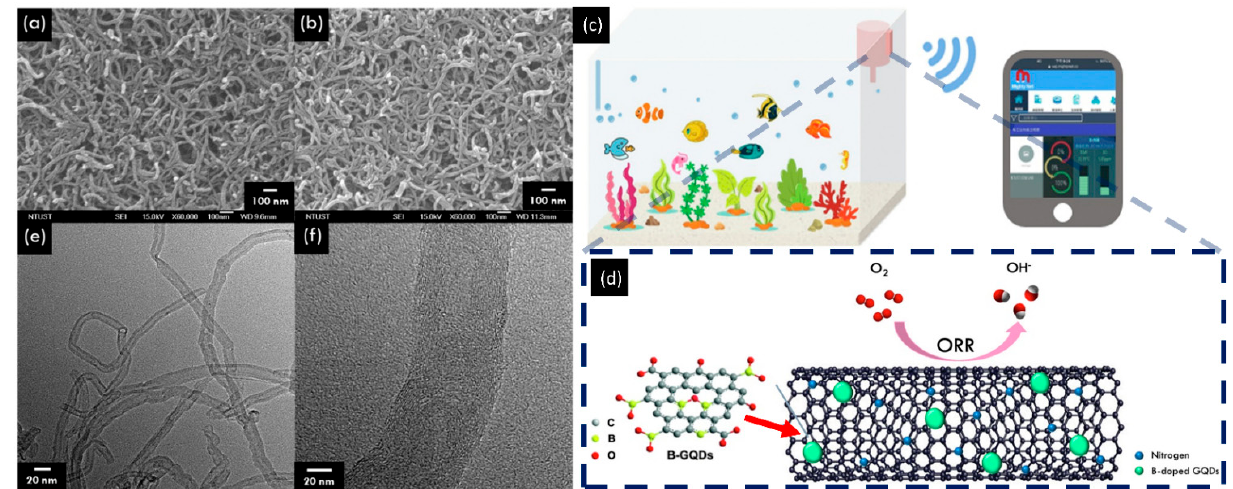
Figure 7. FE–SEM images of ( a ) CNTs, ( b ) NCNTs, ( c ) scheme of the practical application of determining dissolved oxygen, ( d ) scheme of BGQD/NCNT sample, TEM images of obtained samples in ( e ) low magnification and ( f ) high magnification. Adapted from [123], with permission from Carbon, 2022.